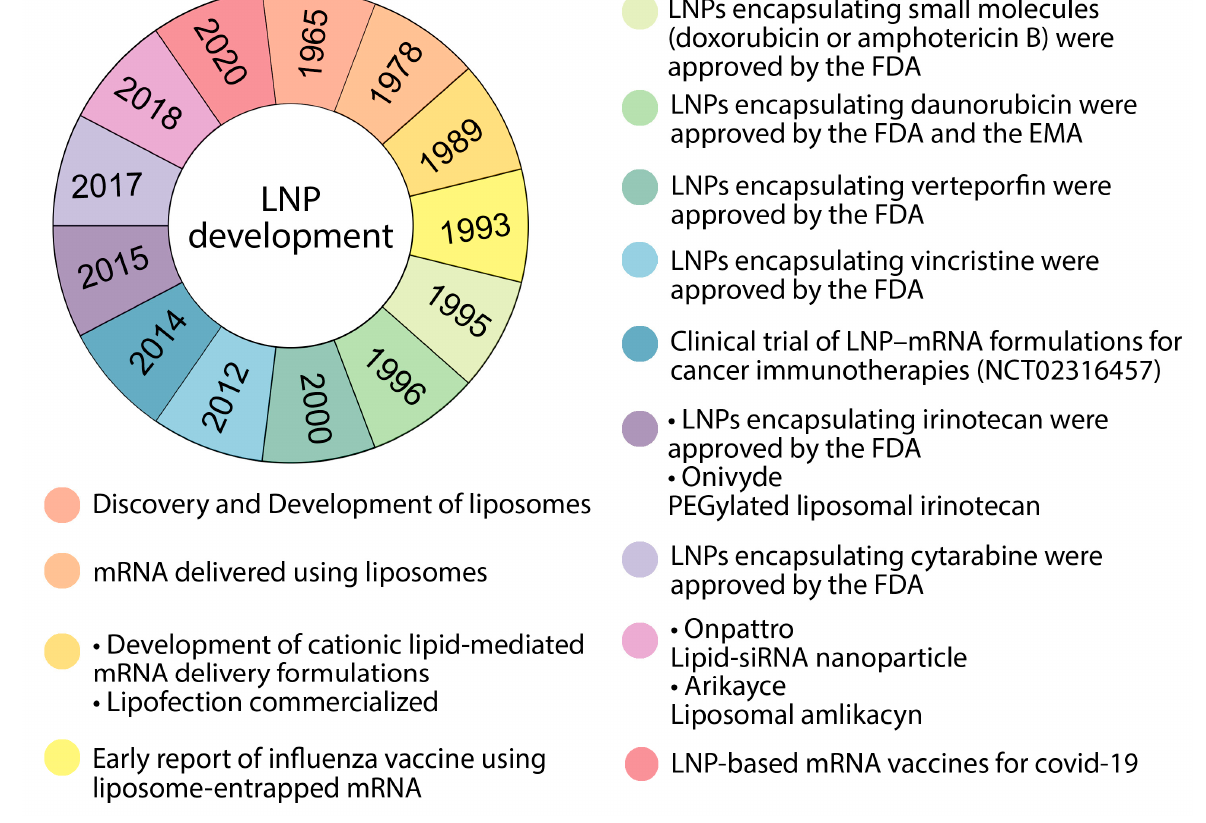
Figure 3. Timeline of some important events for LNP development. FDA: United States Food and Drug Administration, EMA: European Medicines Agency, LNP: lipid nanoparticle.